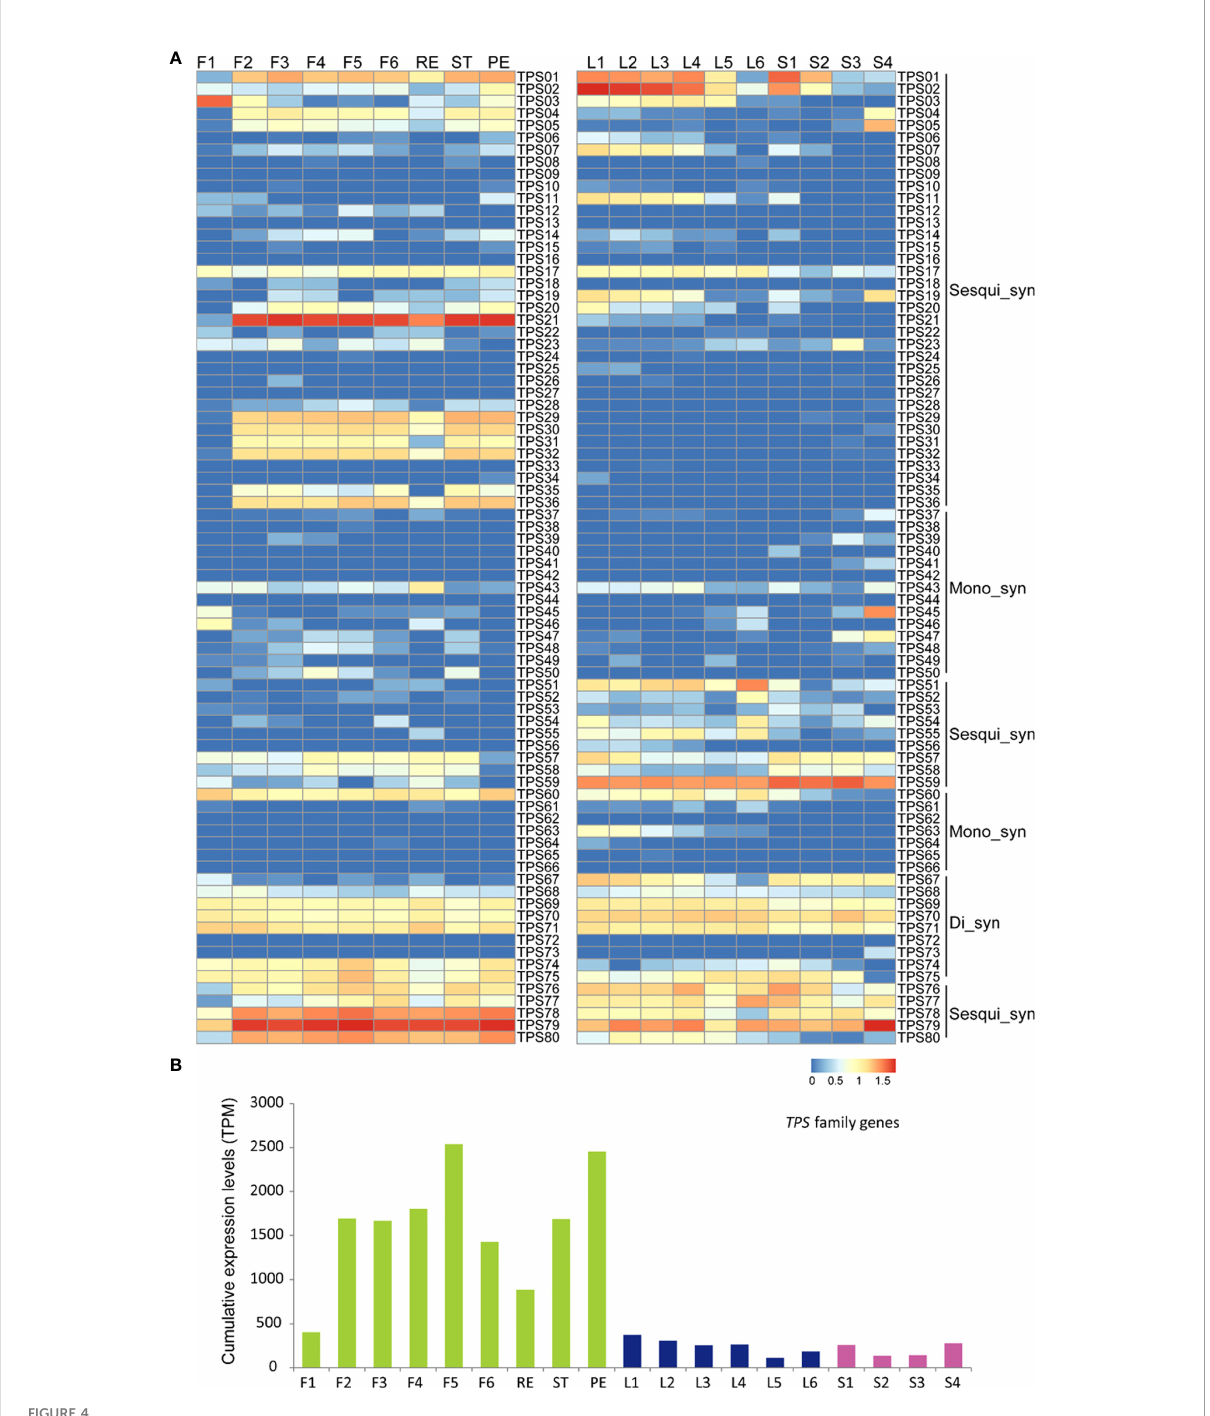
FIGURE 4 Expression analysis of TPS gene family in tea developing fl owers and leaves. (A) Heat map expression analysis of TPS genes involved in the terpenoid process in tea developing fl owers and leaves. F1, tea fl ower stage 1; F2, tea fl ower stage 2; F3, tea fl ower stage 3; F4, tea fl ower stage 4; F5, tea fl ower stage 5; F6, tea fl ower stage 6; ST, stamen; PE, petal; RE, receptacle; L1, fi rst tea leaf; L2, second tea leaf; L3, third tea leaf; L4, fourth tea leaf; L5, fi fth tea leaf; and L6, sixth tea leaf; S1, internode between the fi rst leaf and second leaf; S2, internode between the second leaf and third leaf; S3, internode between the third leaf and fourth leaf; S4, internode between the fourth leaf and fi fth leaf; Mono_syn, monoterpene synthase; Sesqui_syn, sesquiterpene synthase; Di_syn, diterpene synthase. The expression level [log10(FPKM)] of each gene is shown in the heat map boxes. (B) Cumulative expression analysis of the TPS family genes in tea developing fl owers and